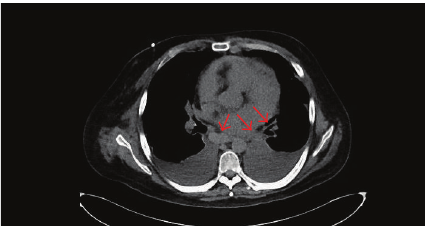
Figure 2: Chest CT with circumferential pericardial and nodular soft tissue densities posterior to the heart as denoted by red